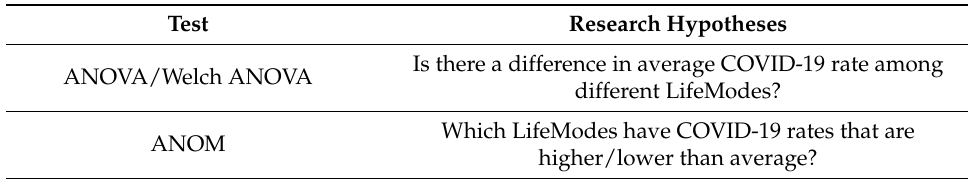
Table 2. Summary of statistical tests performed and research